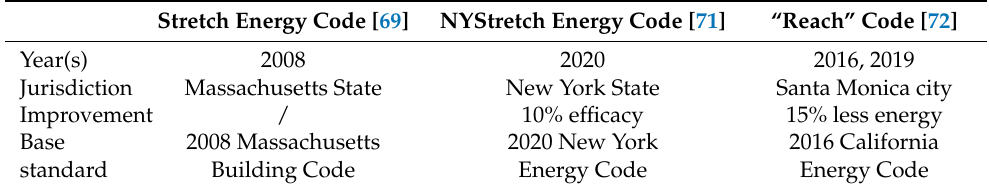
Table 3. Summary of stretch